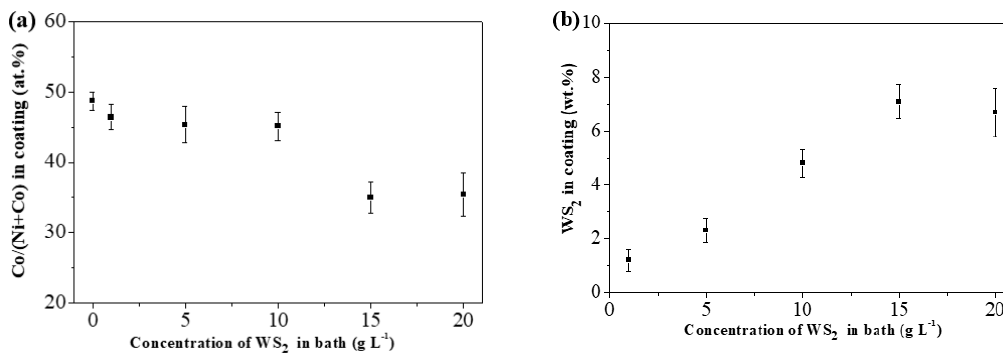
Figure 5. ( a ) The mol ratio of Co/(Co + Ni) and ( b ) the content of WS 2 particles in coating versus the